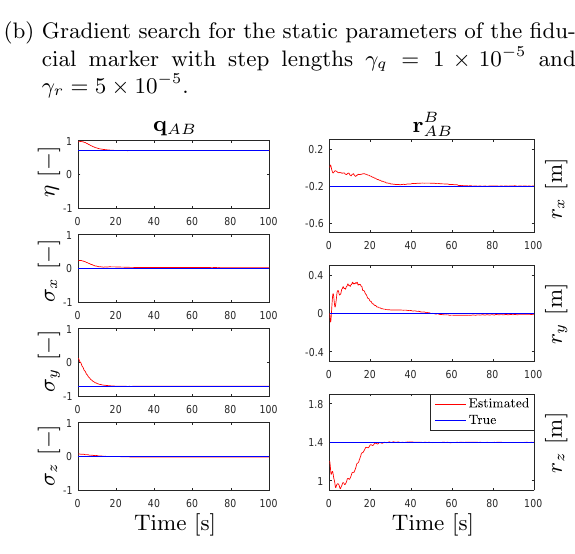
Figure 3: Simulation with parameter estimation. The plots show the results when the static param- eters were initially